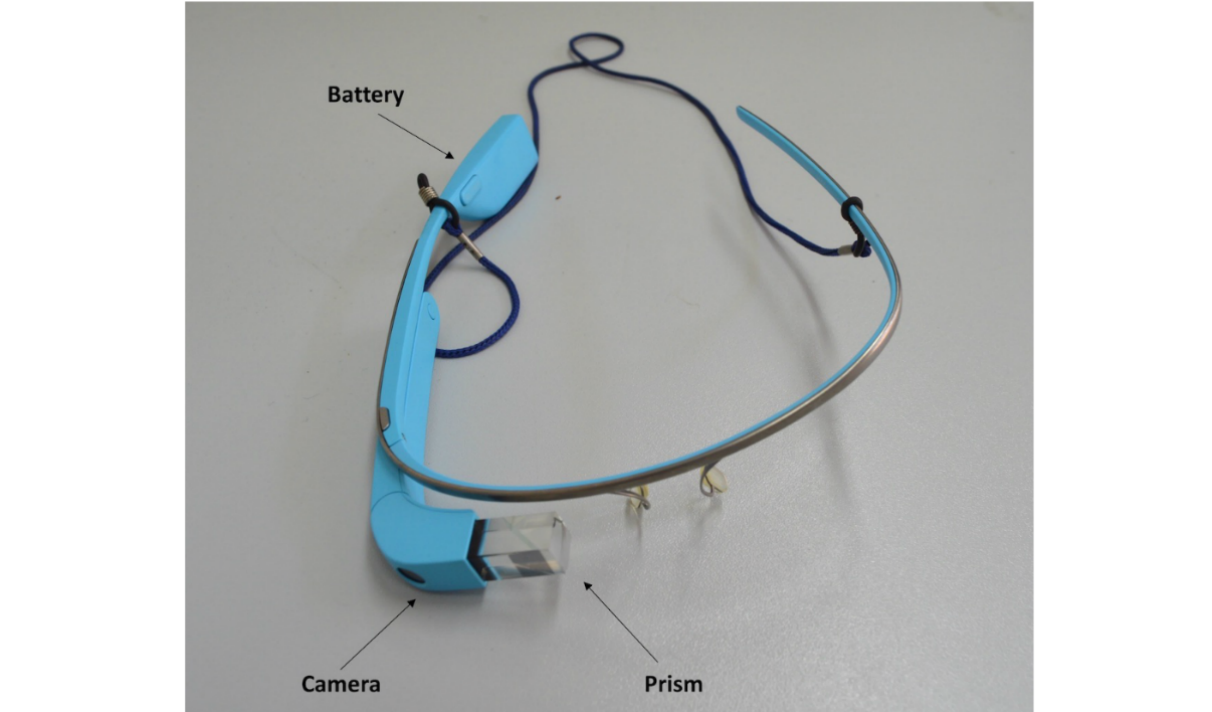
Figure 1. Google Glass device.